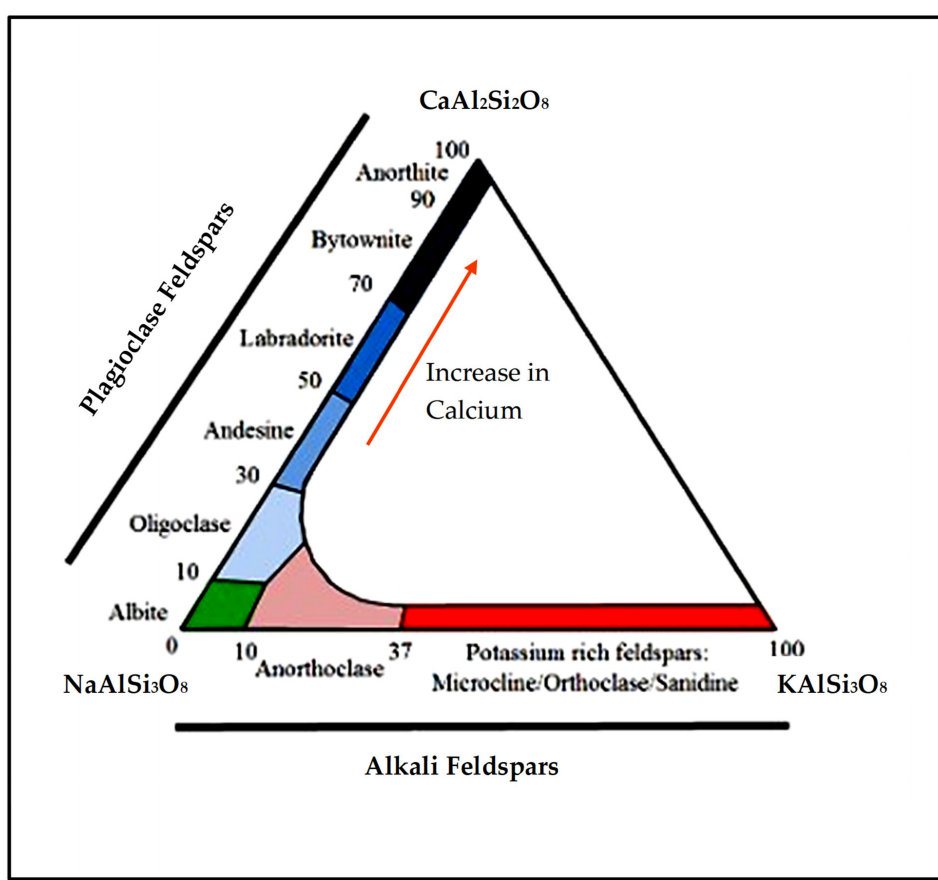
Figure 6. Various minerals that form part of the Feldspar group of materials